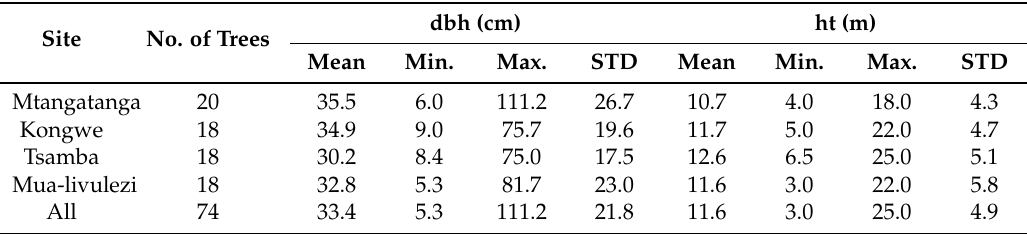
Table 2. Mean, minimum, maximum and standard deviation (STD) of diameter at breast height (dbh) and total tree height (ht) for sample trees at each